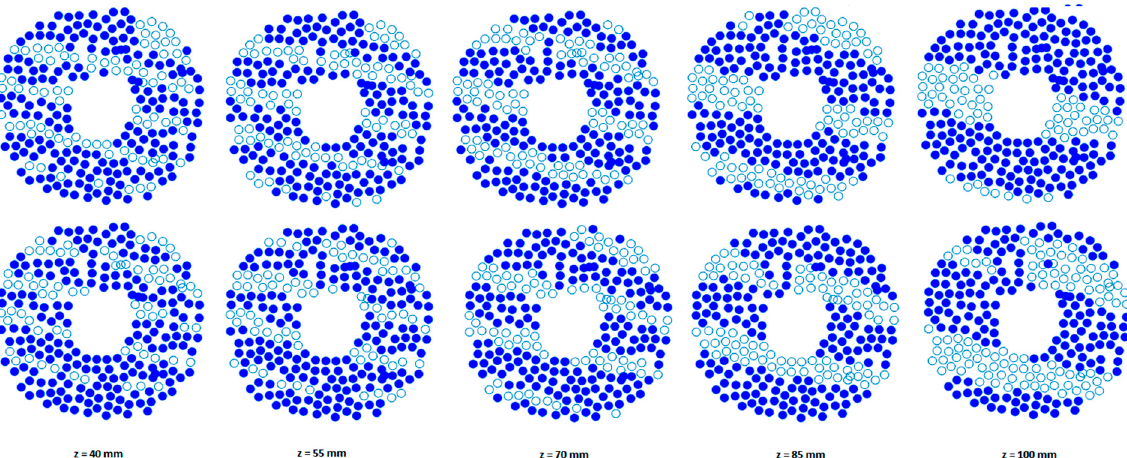
Figure 12. Active elements when the ribs are positioned at different heights [40,55,70,85,100] mm. Blue filled circles indicate elements that are turned ON for HIFU and unfilled circles indicate elements which are blocked by ribs and turned OFF. When the array axis crosses: middle of rib 9 ( top row ), middle of the space between ribs 9 and 10 ( bottom row ).